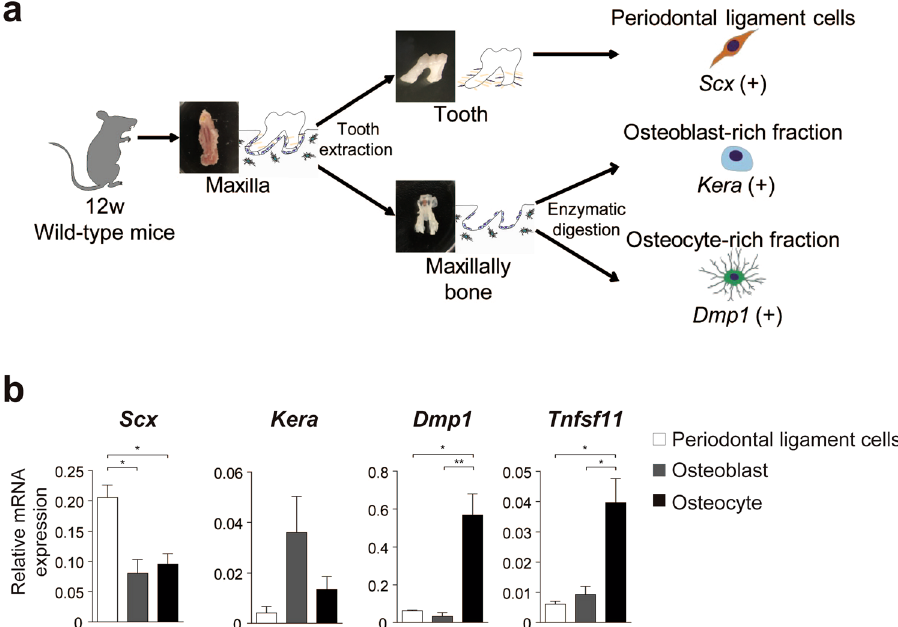
Figure 3. RANKL expression in periodontal tissues. ( a ) Establishment of isolation of cells from periodontal tissue. Periodontal ligament cells, osteoblasts and osteocytes were collected according to the schematic flow chart (see methods). ( b ) Profiling of gene expression in periodontal ligament cells, osteoblasts and osteocytes (quantitative RT-PCR analysis) (n = 5 per each fraction). Statistical analysis of Dmp1 expression was carried out using Kruskal-Wallis test and Dunn’s multiple comparison test. Error bars, means ± s.e.m.; * P < 0.05; ** P <